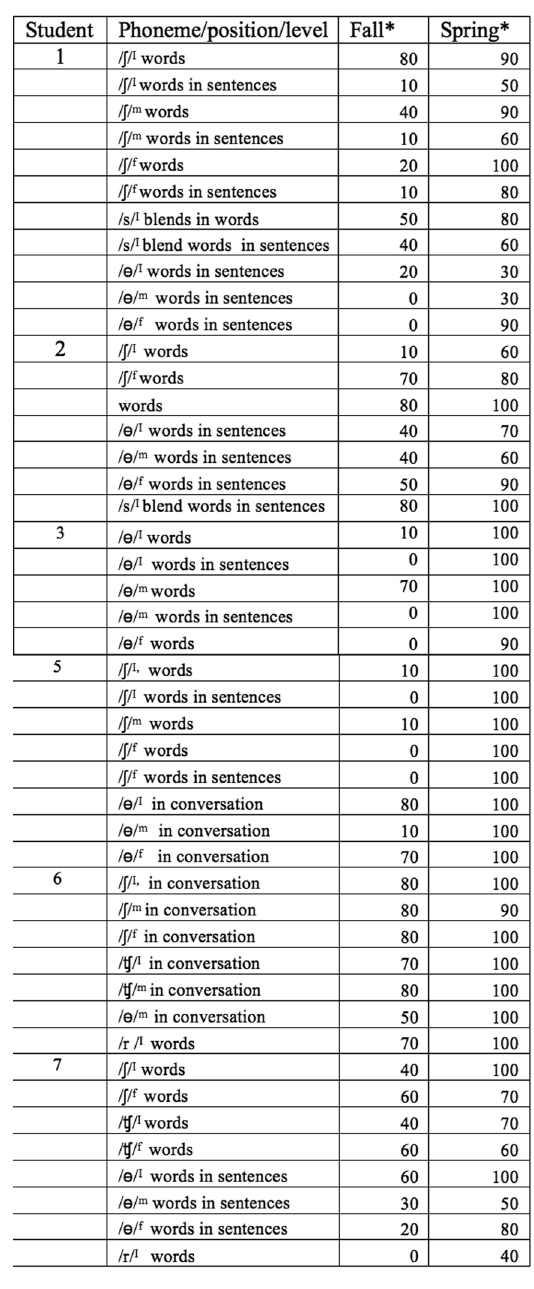
Table 4. Telehealth group baseline and post-intervention production levels for target